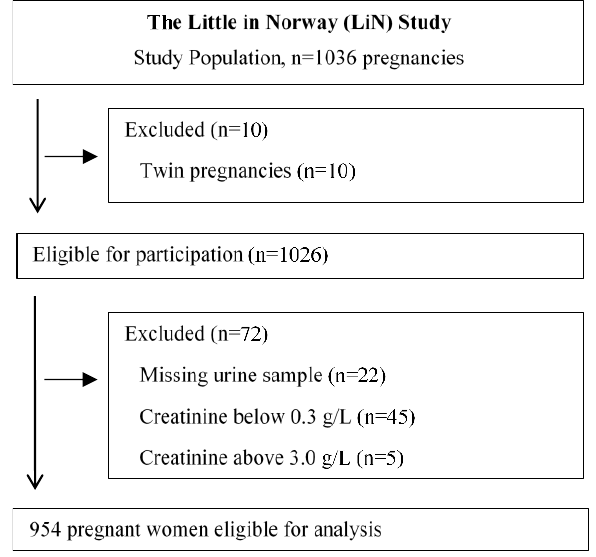
Figure 1. Flowchart of study participants in the current study.